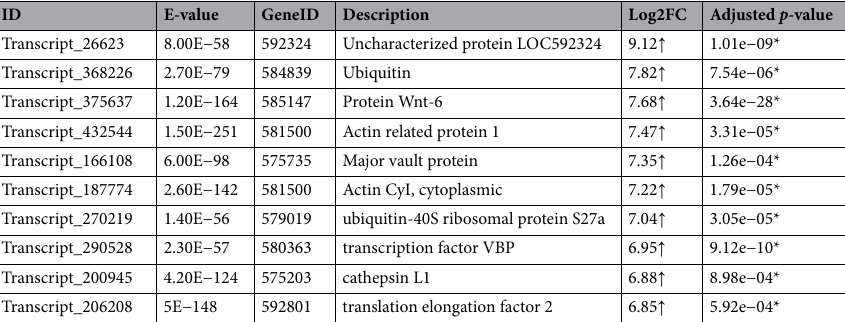
Table 3. Top 10 upregulated DEGs at day 3 of regeneration. ↑ : Upregulated (Log2FC > 2); *: Significant ( p value < 0.01); Log2FC: Log 2 Fold